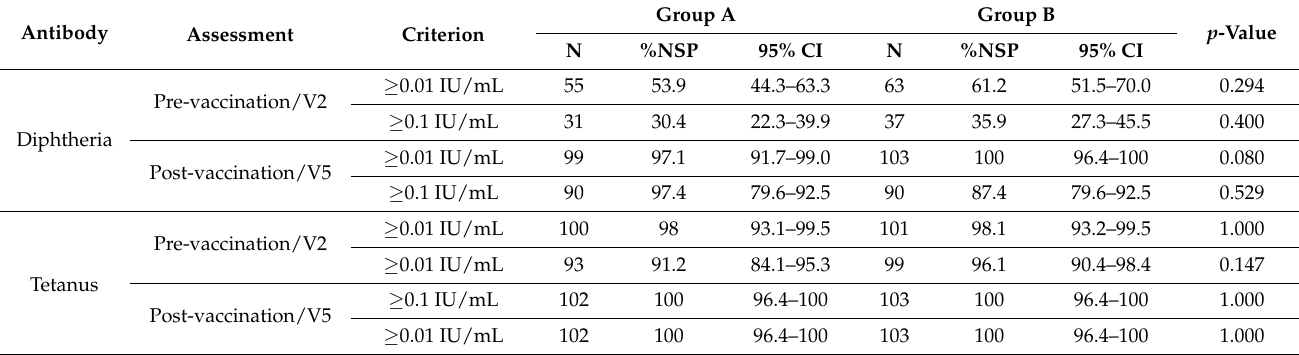
Table 4. Summary of seroprotective antibody